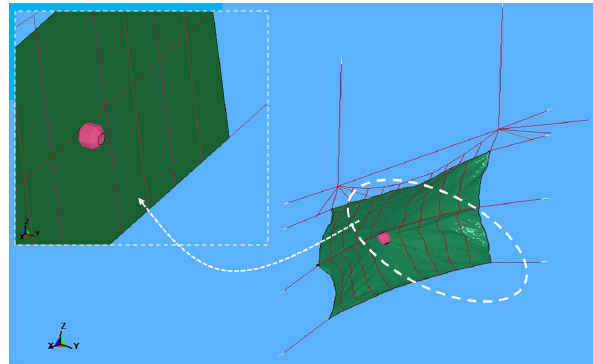
Figure 10. The verified FE model of the R-LPR now impacted by the ETAG027-like block 2 Fig. 10. The verified FE model of the R-LPR now impacted by the ETAG027-like